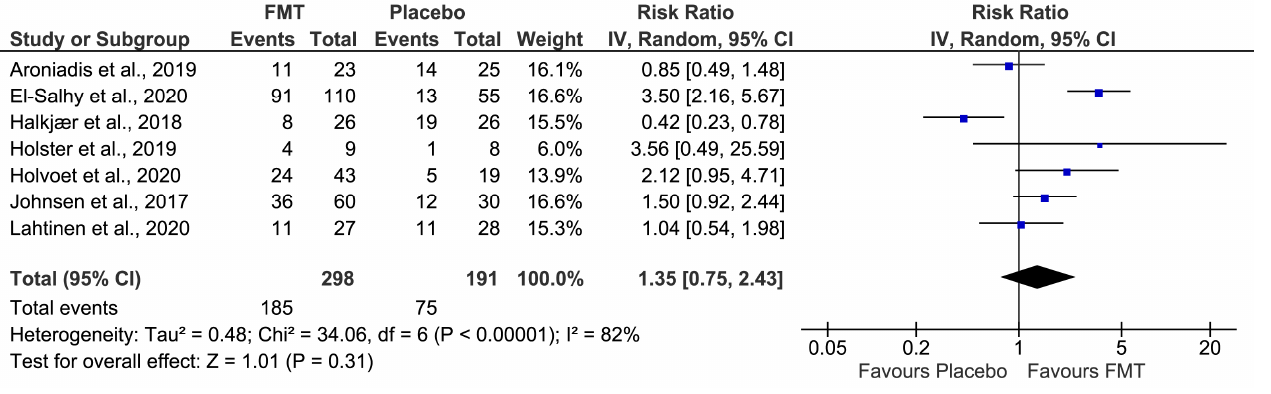
Figure 2. Forest plot of all studies for efficacy of FMT vs. placebo on global improvement of IBS symptoms. Aroniadis et al., 2019 [31] , El-Salhy et al., 2020 [32] , Halkjær et al., 2018 [33] , Holster et